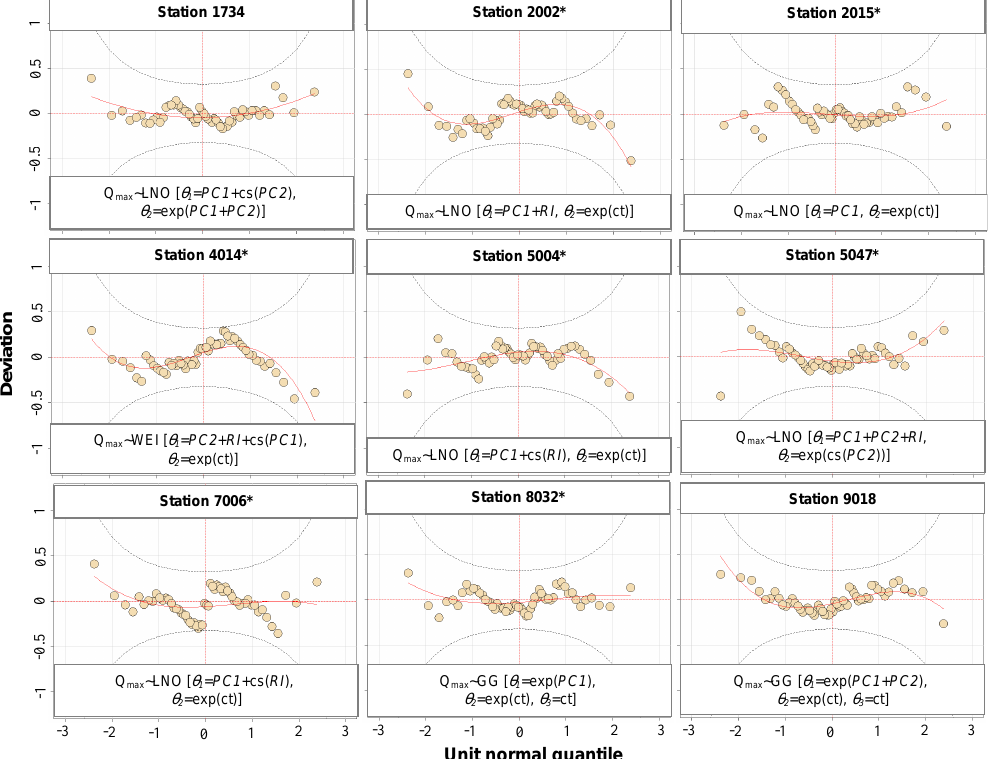
Figure 4. Worm plots of model 2 residuals for nine representative sites (* means altered regime). The two black dotted lines correspond to the 95% confident limits.